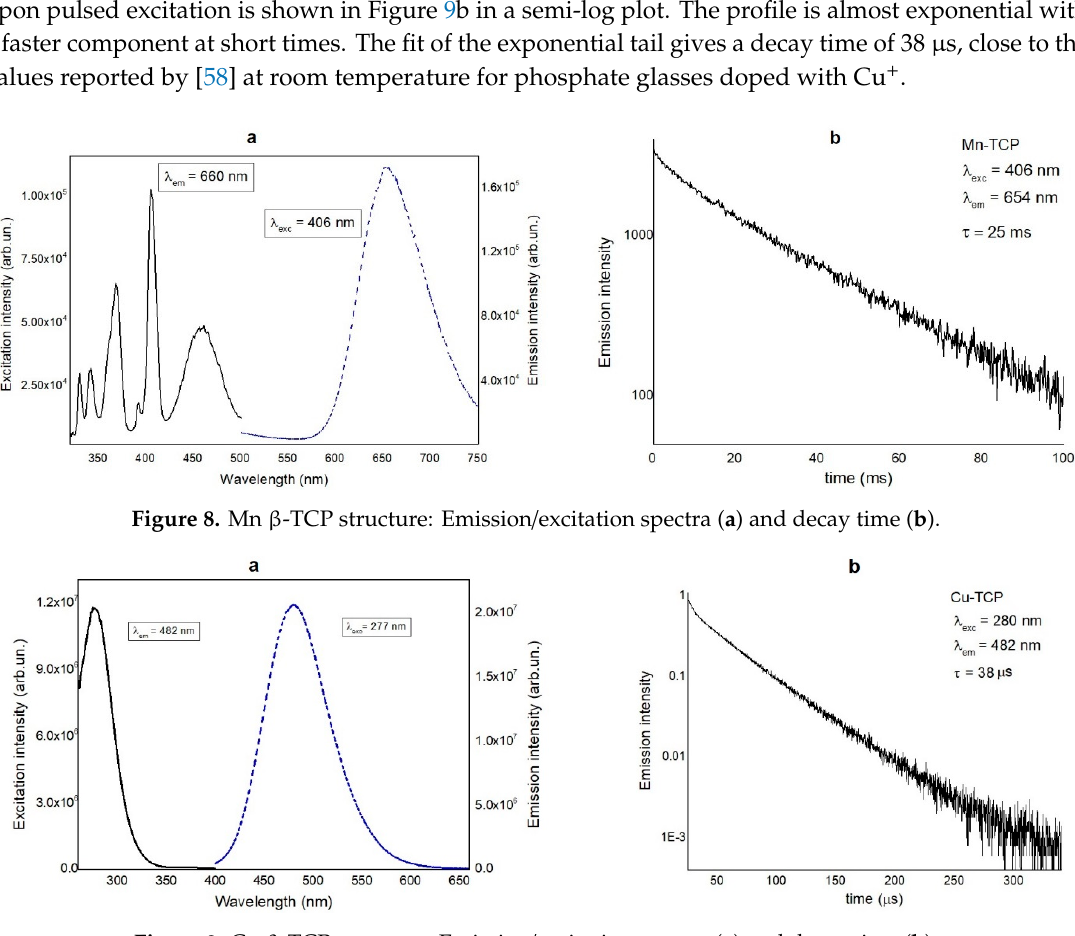
Figure 9. Cu β -TCP structure: Emission/excitation spectra ( a ) and decay time ( b ).